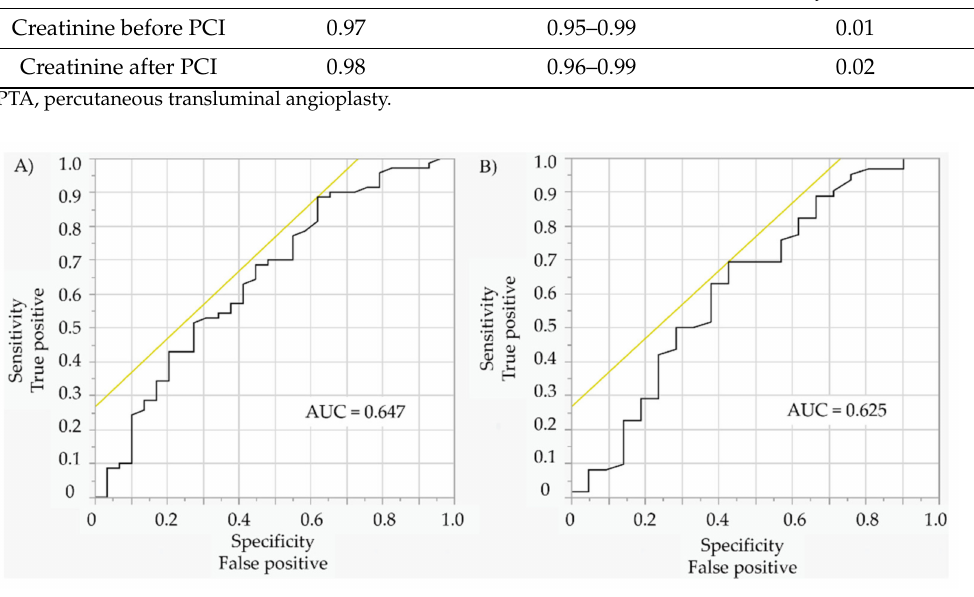
Figure 2. ( A ) Receiver operating characteristic curve of the relationship between pre-procedural creatinine serum concentration and stent expansion ( ≥ 90% vs. <90%). ( B ) Receiver operating characteristic curve of the relationship between post-procedural creatinine serum concentration and stent expansion ( ≥ 90% vs.